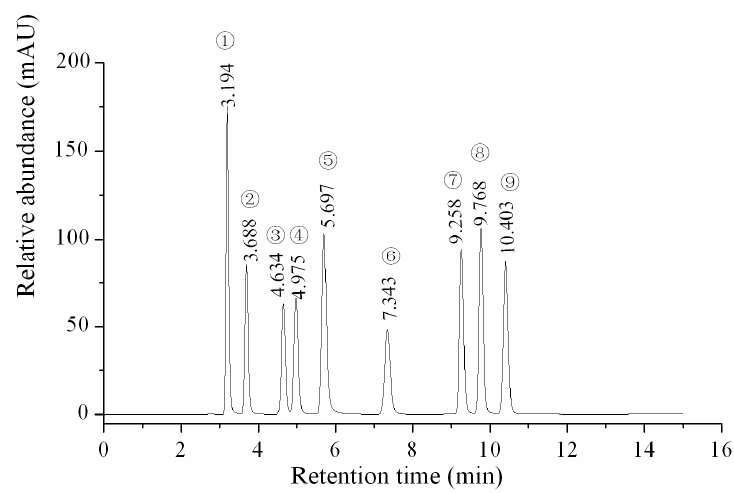
Figure 1. HPLC profile of the standard samples. ① Uracil; ② Uridine; ③ Inosine; ④ Guanosine; ⑤ Adenine; ⑥ Thymidine; ⑦ Adenosine; ⑧ 2-deoxyadenosine; ⑨ Cordycepin.